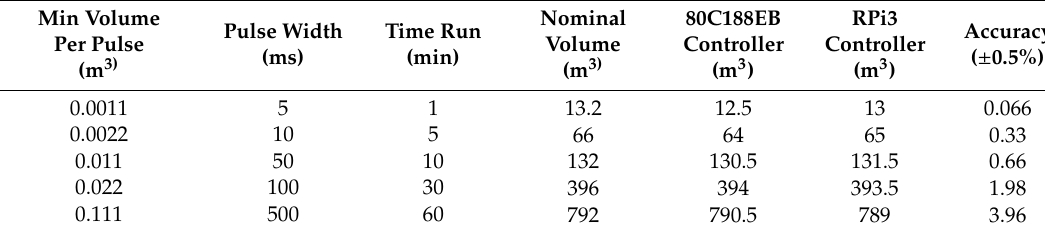
Table 1. Experimental results of volume